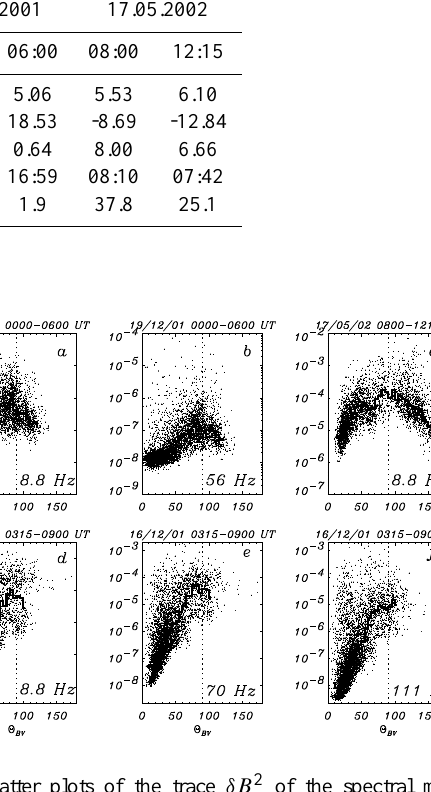
the median line for 2 BV ’ 90 ◦ and a strong curvature of the scatter plot at 8.8 Hz (Fig. 1d), as well as at 70 Hz and 111 Hz (Figs. 1e and 1f). As mentionned in the Introduction, the fluctuating fields are made of several components. This is clearly shown by histograms of the PSD δB 2 at a given frequency, and histograms of the phase difference φ B 1 B 2 between the two components δB 1 and δB 2 perpendicular to the local B field (Fig. 2). In the histogram of Fig. 2a, the solid line corre- sponds to the data of the scatter plot of Fig. 1a: this is a nearly Gaussian distribution, at 8.8 Hz. The corresponding phases φ B 1 B 2 (Fig. 2b) are around 0 ◦ and 180 ◦ and imply a linear polarisation. Whistler waves, which are right-handed, should appear as a peak at φ B 1 B 2 ’ 90 ◦ , if they were intense enough. The dotted line in Fig. 2a gives the histogram of the PSD of the fluctuations with φ B 1 B 2 = 90 ◦ ± 10 ◦ : these whistler waves have a negligible power at 8.8 Hz. The histogram (solid line) of Fig. 2c corresponds to the data of Fig. 1e at a